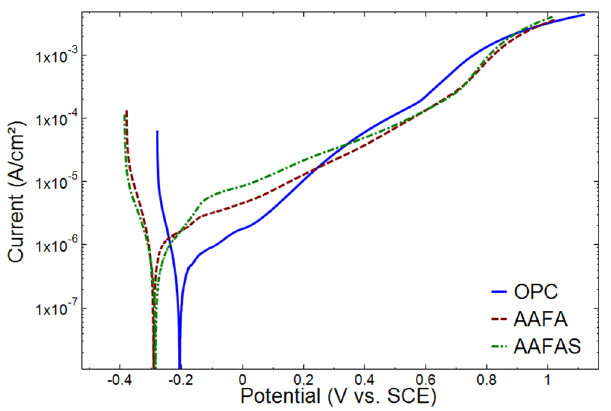
Figure 11. Potentiodynamic polarization curves of steel reinforcement embedded in OPC, AAFA, and AAFAS concretes after leaching.